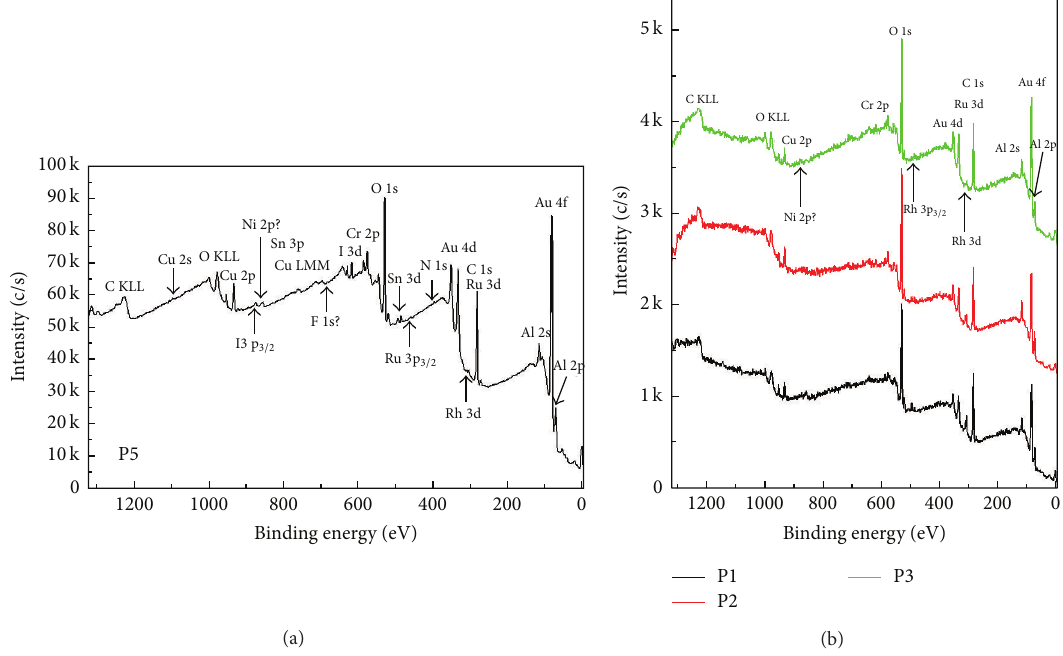
Figure 8: XPS spectra measured in point P5 (a) and points P1–P3 (b) shown in Figure